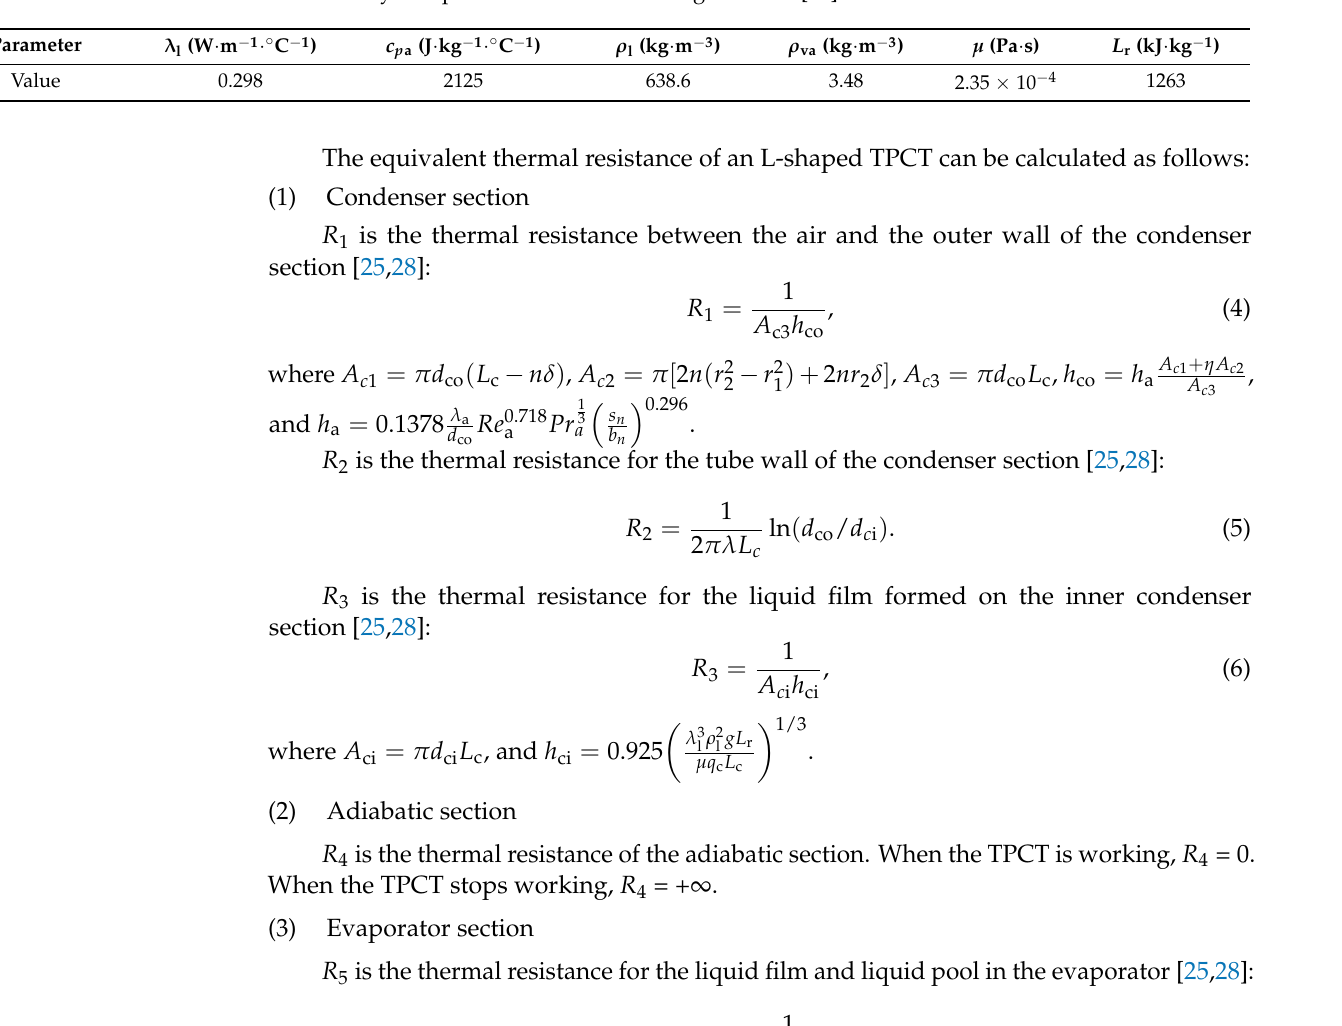
Table 2. Physical parameters of the working medium